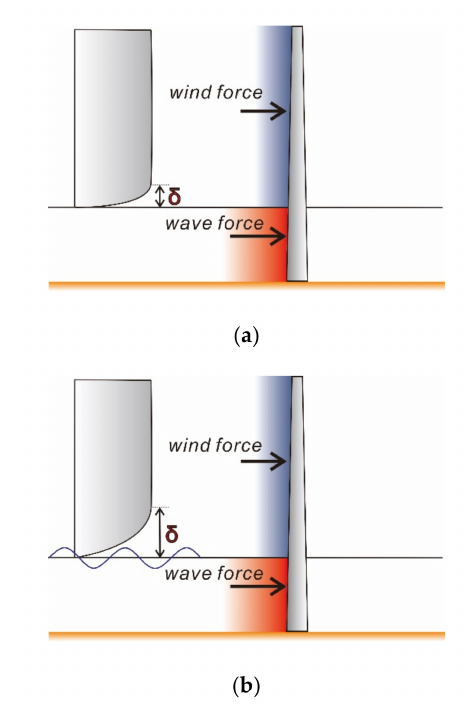
Figure 2. Schematic sketch of thickened boundary layer owing to the presence of waves and definition sketch of boundary layer thickness ( δ ) ( a ) calm sea and ( b ) rough